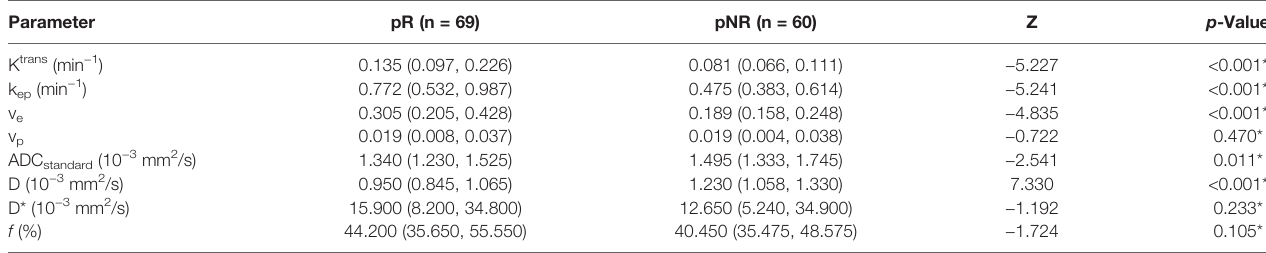
TABLE 2 | Comparison of DCE-MRI and IVIM quantitative parameters between pR and pNR groups. Parameter